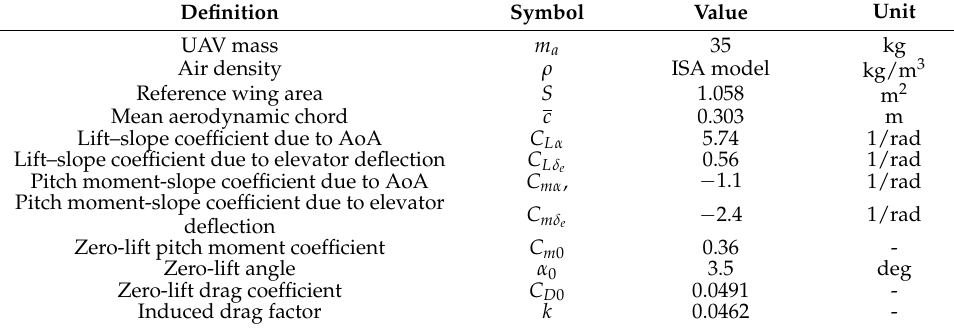
Table A2. UAV model parameters.